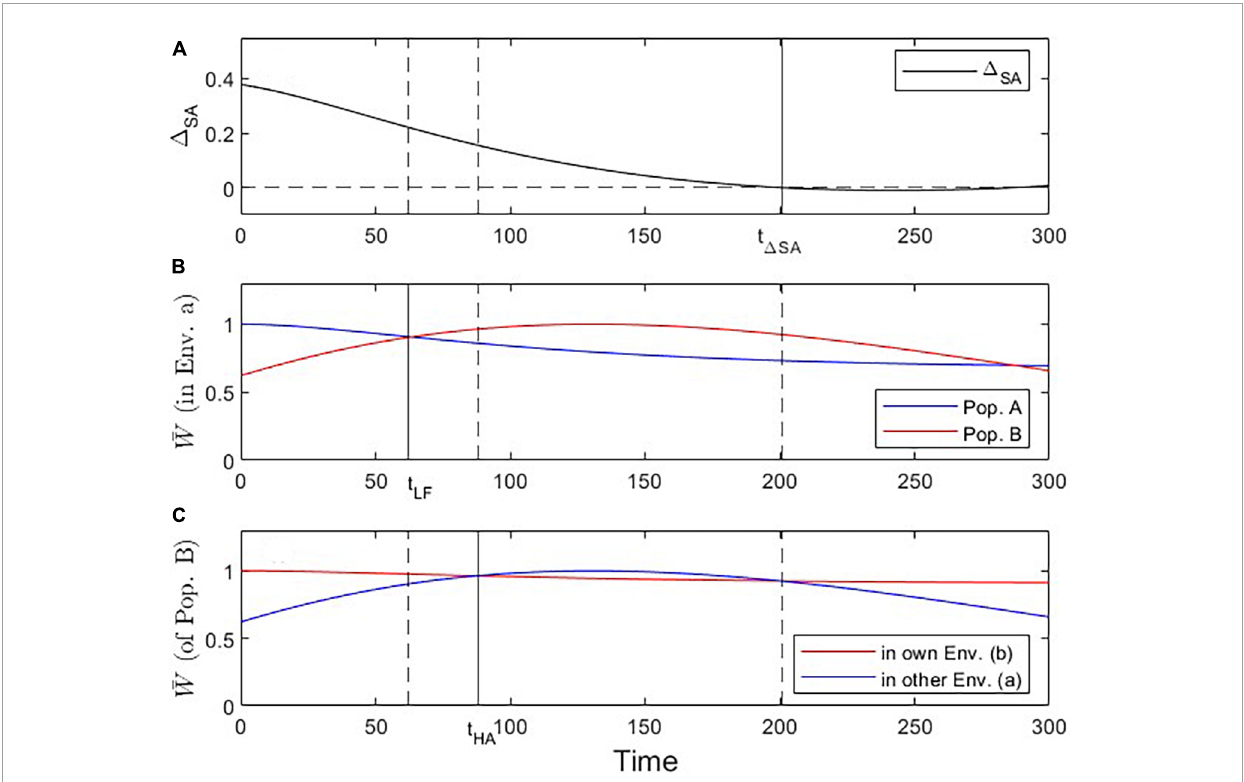
FIGURE6 Visualization of three critical checkpoints (vertical lines) during the evolutionary dynamics under Scenario 3. (A) Evidence for local adaptation by the (cid:49) SA contrast criterion (at t ≤ 201). (B) Fitness of population A vs. B in environment a (addressing the Local vs. Foreign criterion; t crit = 62). (C) Fitness of population B in own vs. other environment (addressing the Home vs. Away criterion; t crit = 88).